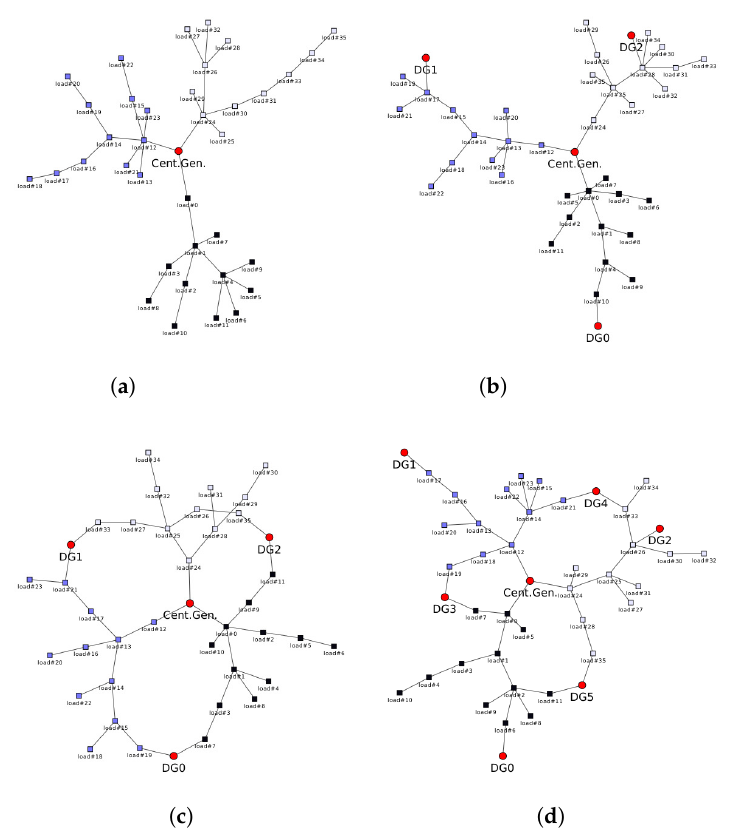
Figure 3. Random grid topologies. Rectangular nodes are loads, red circles are generators. Colors of the loads encode the cables they belong to. ( a ) Radial grid with single generator. ( b ) Radial grid with DGs. ( c ) Meshed grid with DGs between cables. ( d ) Meshed grid with DGs between and at